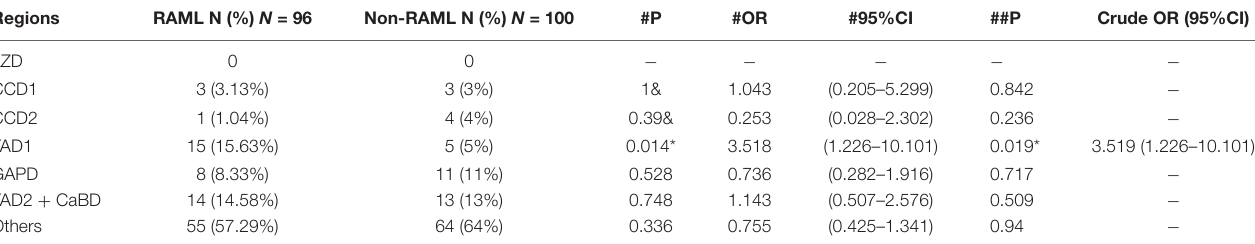
TABLE 2 | Relationship between mutations of exon gene in TSC2 coding functional regions and RAML.